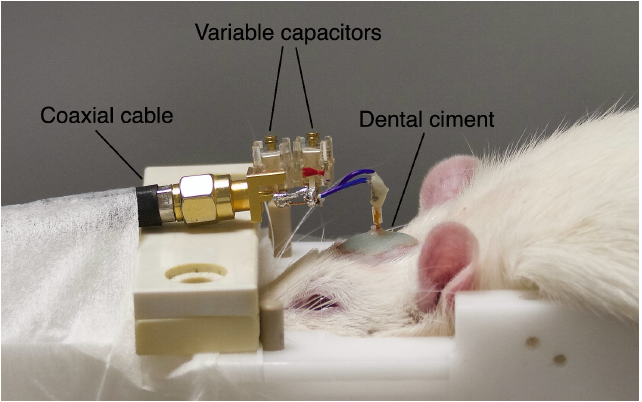
Figure 5. Illustration of the experimental